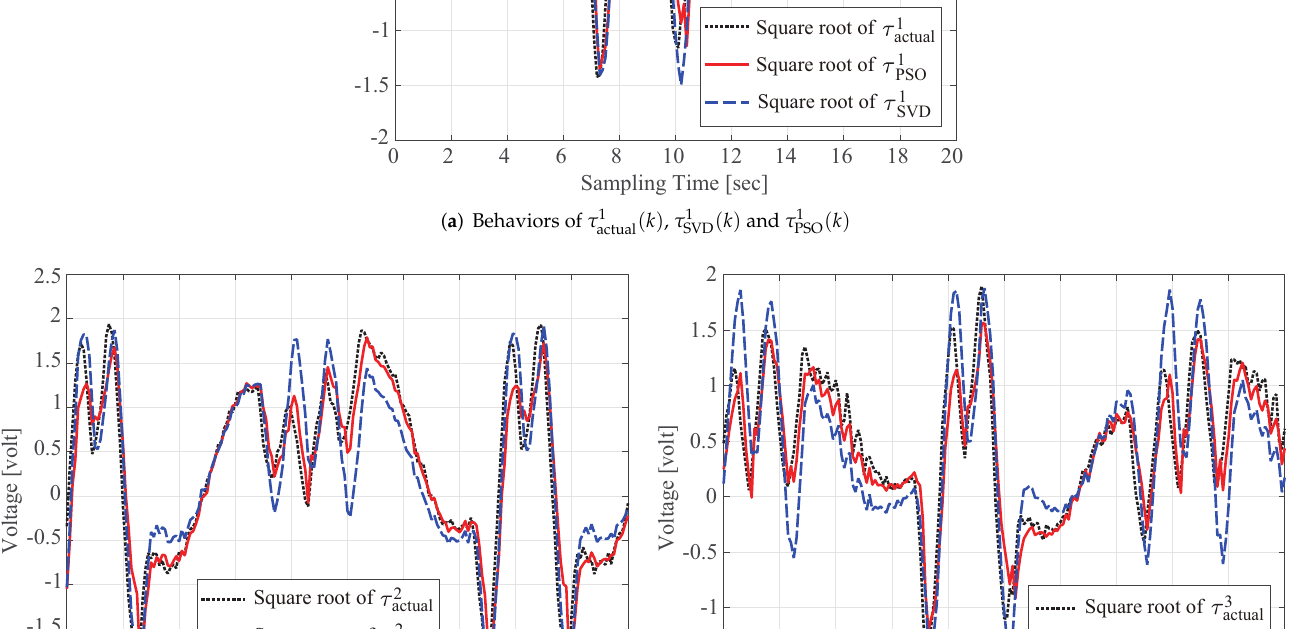
( k ) computed using (26) with the identified parameter values PSO